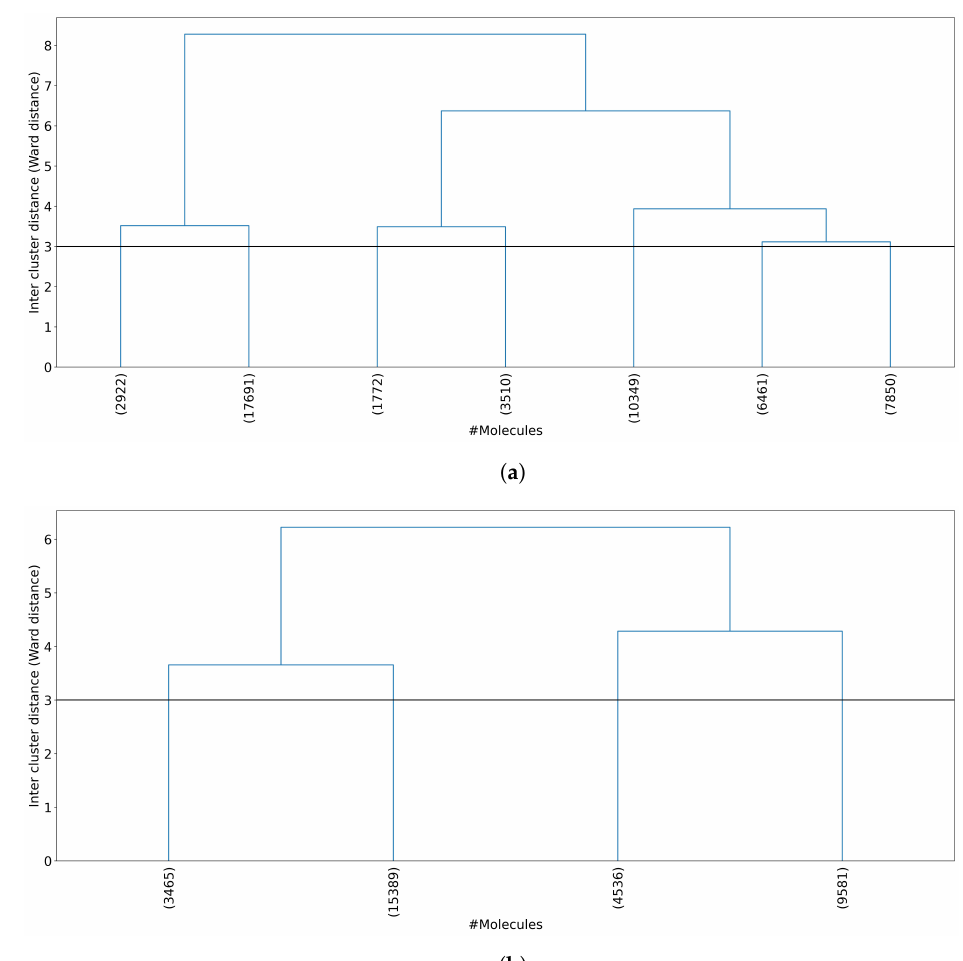
Figure 4. Dendrogram representation of hierarchical clustering results. ( a ) Clustering of all 50,555 molecules results in 7 clusters at a Ward linkage cutoff of 3. ( b ) Clustering of 32,971 non-outlier molecules results in 4 clusters at a Ward linkage cutoff of 3. For each plot, the horizontal axis shows the number of molecules per cluster, and the vertical axis shows the Ward linkage between any two clusters. Outlier molecules were removed using an outlier cutoff of 0.5 (see Section 3.1 for more details about outlier detection). The average cluster size is 7229 molecules (std = 5517) when all molecules are clustered and 8243 molecules (std = 5460) when non-outlier molecules are